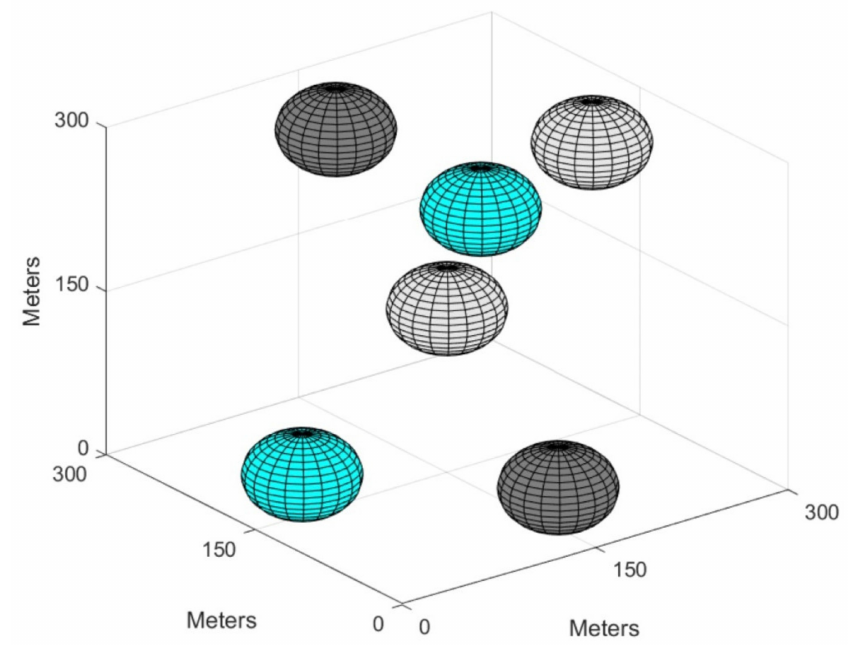
Figure 15. Four nodes in sleep mode, but with di ff erent timers and two nodes in active mode. With the scheme of these figures, we intend to visually the state of the nodes: active or sleep mode. The figures show the area of the campus engineering building comprised of 300 square meters. The spheres represent the nodes located in the studied scenario. The di ff erent colors of the spheres represent that the nodes are in di ff erent states during the simulation time. The LEI algorithm is based on timers to sleep the nodes. Therefore, we wanted to evaluate the three possible states in which the nodes were distributed in the